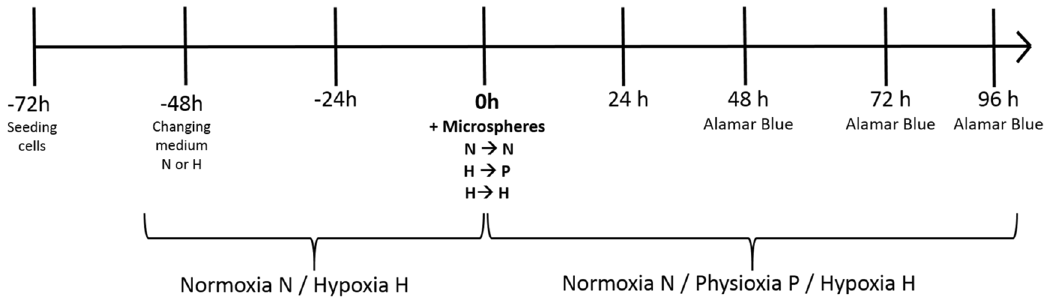
Figure 3. Experiment protocol. (N- Normoxia 19% O 2 , P- Physioxia 5% O 2 , H- Hypoxia 1% O 2